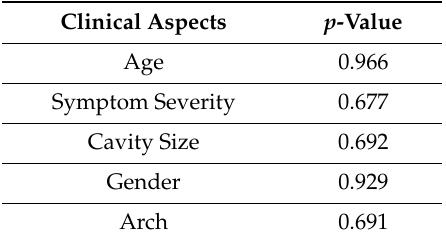
Table 2. Association between clinical outcome and clinical aspects at T24.